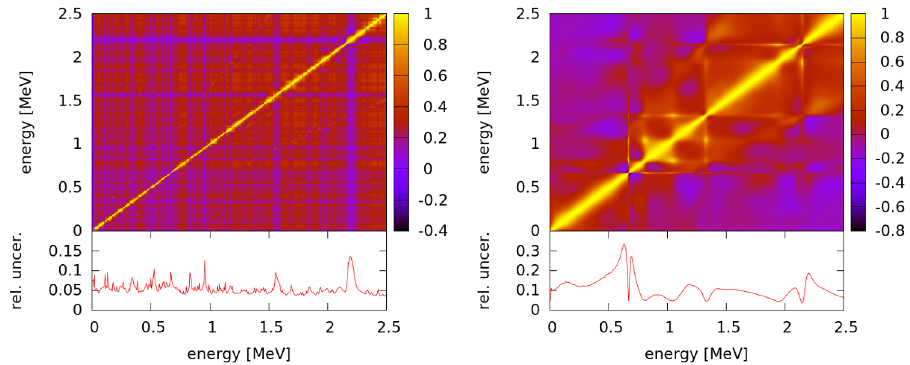
Figure 6. Correlation matrices associated to U 1 (left) and K 1 (right) with their relative uncertainties √ U 1 ( E i , E i ) /σ true and